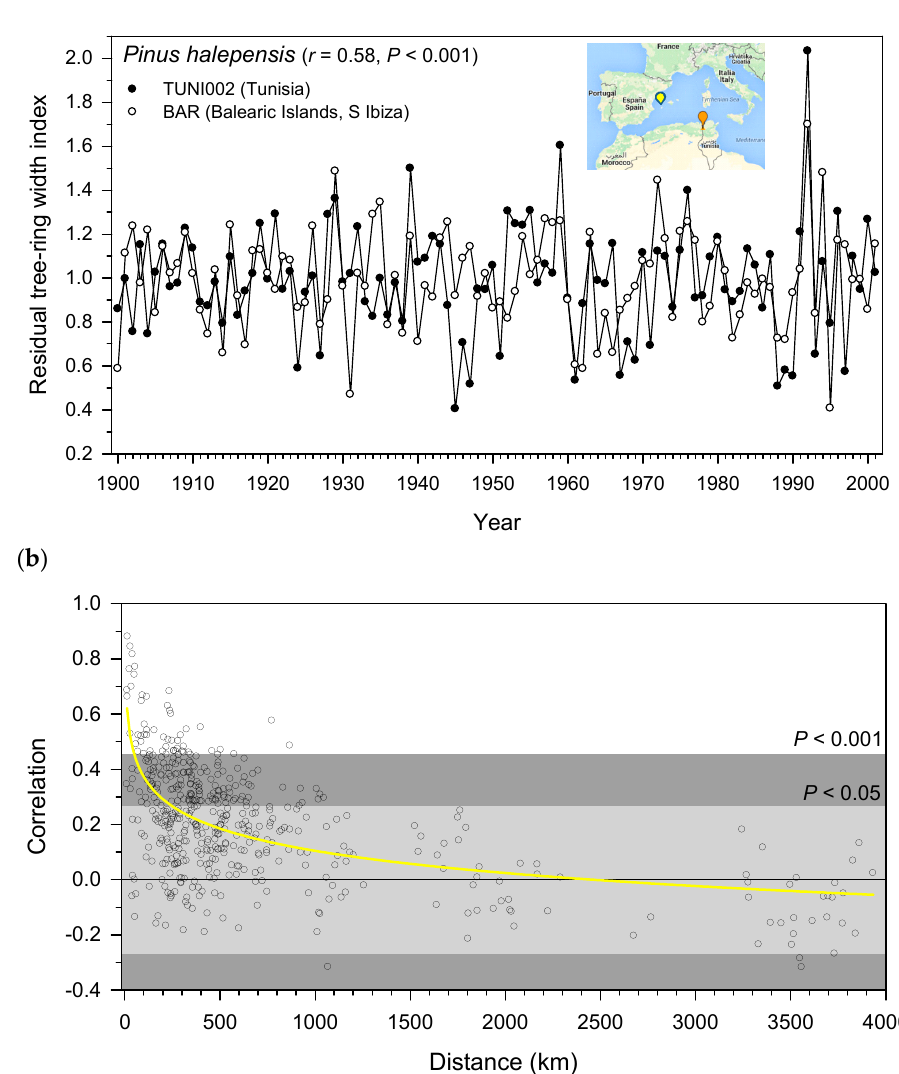
Figure 2. ( a ) Plot illustrating growth variability between two Aleppo pine sites situated in the southern Balearic Islands (Ibiza, site BAR) and northern Tunisia (tuni002, southernmost site). The residual chronologies were significantly correlated, despite the sites being located ca. 800 km apart. ( b ) Plot showing Pearson correlation coefficients between Mediterranean Aleppo pine chronologies decays as a function of distance between sites. The different grey intensities of the two boxes indicate the 0.05 and 0.001 significance levels for the analyzed 1950–1999 period. The yellow line shows a logarithmic function to describe the decay of correlations as a function of inter-site distance.